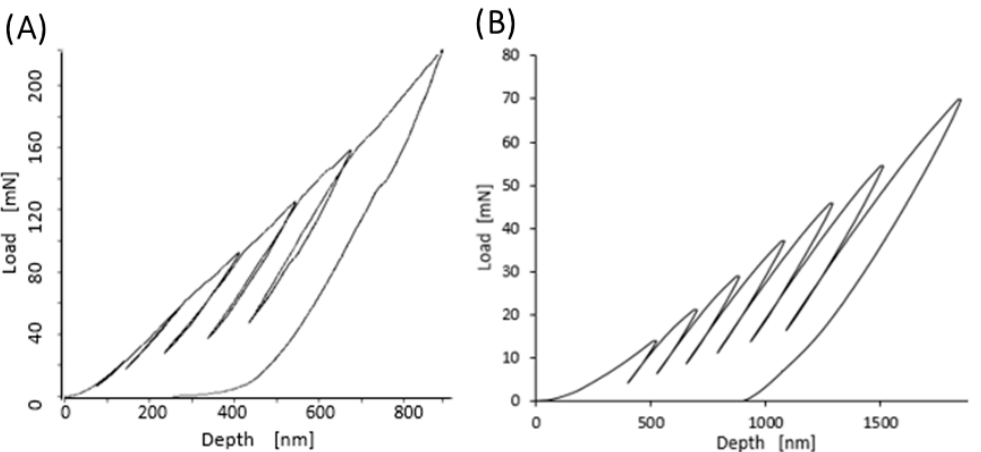
Figure 6. Sample load and unload curves obtained in a multiple-load cycle with an increasing load for diamond nanosheet—( A ), and for a nylon coating with a thickness of 500 nm—( B ). Materials 2019 , 12 , x FOR PEER REVIEW